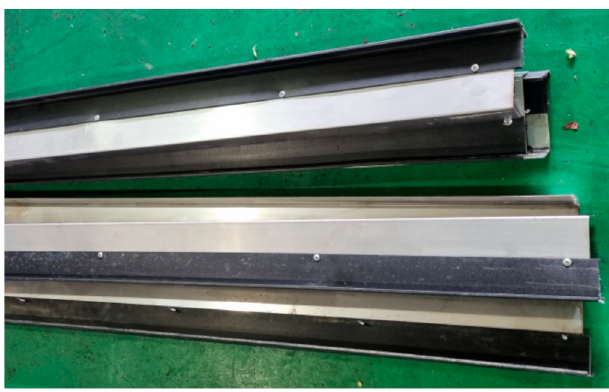
Figure 5. L-shaped stainless-steel track with polyamide